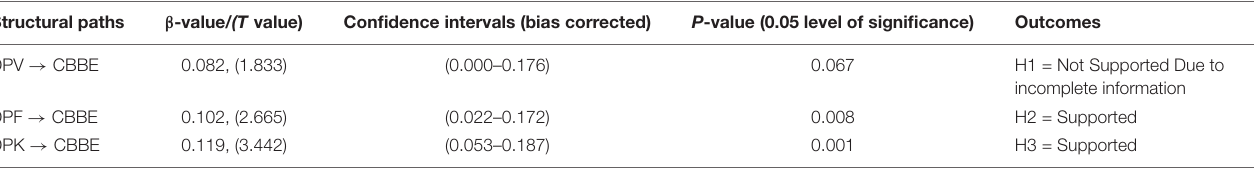
TABLE 5 | significance of structural paths (direct effects). Structural paths